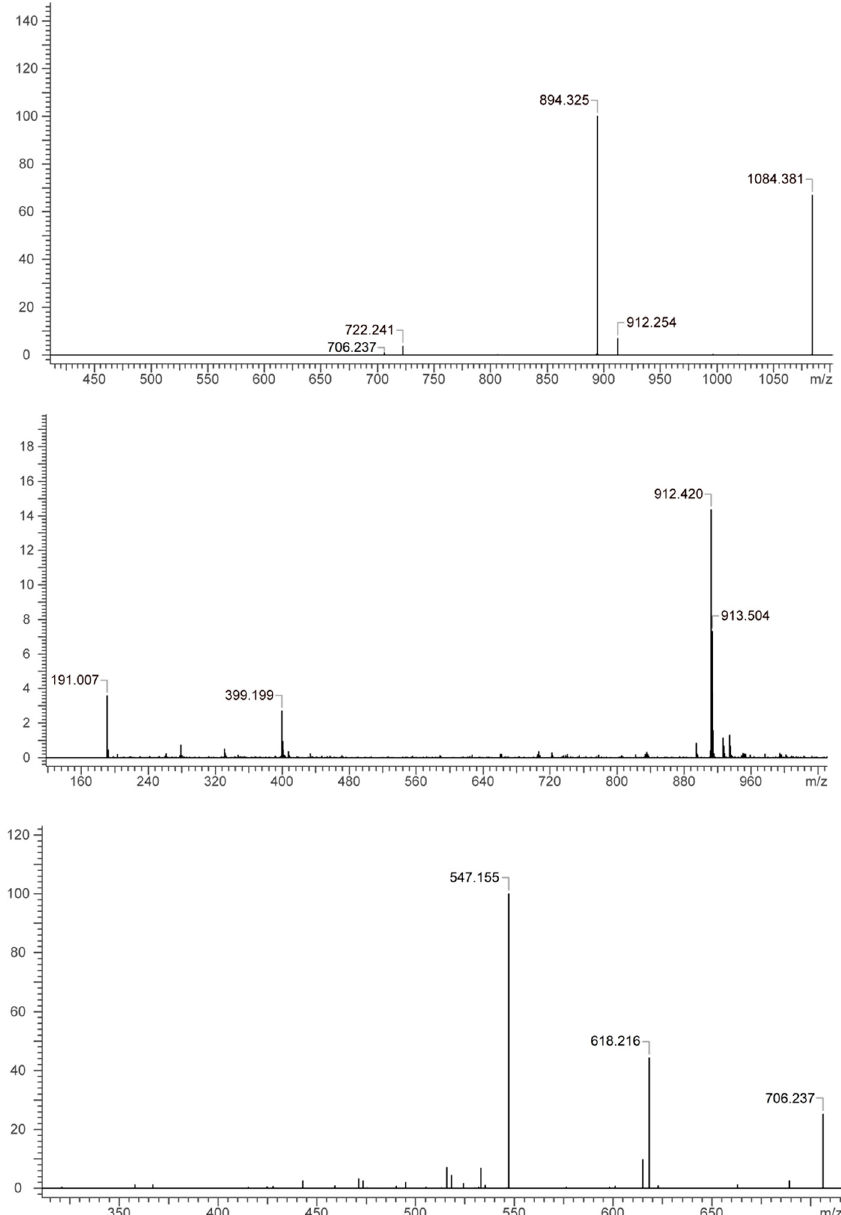
Figure 6. The ESI-MS/MS 2 spectra in acetonitrile of protonated ligand [L + H] + at m/z = 1084, and ESI-MS/MS 3 of signals at m/z = 912 and 706.